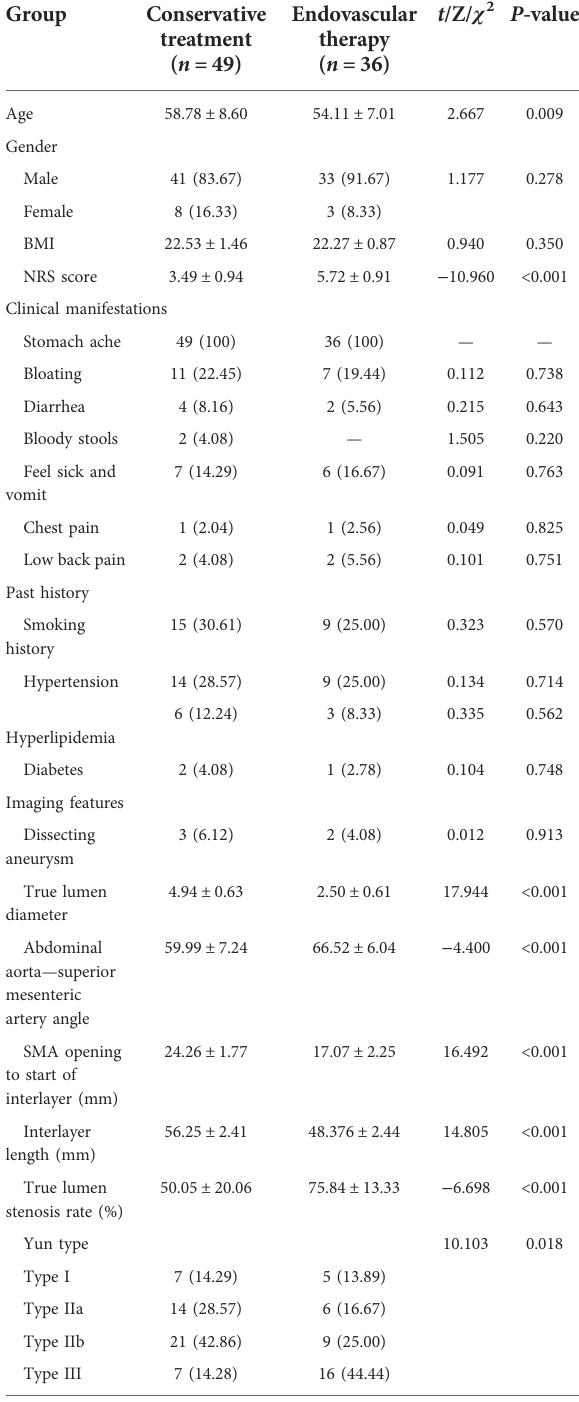
TABLE 3 Comparison of patients in the conservative treatment group and the endovascular treatment group.